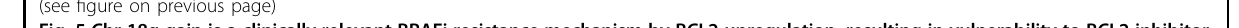
Fig. 5 Chr 18q gain is a clinically relevant BRAFi resistance mechanism by BCL2 upregulation, resulting in vulnerability to BCL2 inhibitor. a Cell viability of the captured clones in response to ABT263. Results are representative of two independent experiments with three technical replicates per experiment, and error bars represent SEM. b Heatmap showing the IC 50 of cells treated with ABT263. c Colony formation assay of cells treated with the indicated drugs. Representative image of three independent replicates. d A violin plot with integrated boxplot showing mRNA expression of BCL2 of BRAFi pre- and post-treatment resistant samples from a published cohort 54 . e Heatmap showing cluster and expression of BCL2 and genes from chr 18q21.33 (labeled in red) or randomly chosen genes from other genomic loci. f , g Pearson correlations of BCL2 expression with the degree of tumor regression (Response Evaluation Criteria in Solid Tumors (RECIST)) or progression-free survival (PFS) from reanalysis of a published cohort 54 . h A boxplot showing Bcl2 expression (FPKM) of paired PLX-treated tumor biopsies (Initial vs Progressed) from a published cohort 55 . i Western blot results showing Bcl2 protein expression of three BRAF mutant melanoma cell lines that were selected for resistant cells by PLX treatment (2 µM for WM2664, 2 µM for SK-MEL-5, and 5 µM for A2058) for 40 days. P parental cells, R1 replicate 1 of PLX-treated cells, R2 replicate 2 of PLX-treated cells. The numbers showing the relative quanti fi cation of Bcl2 bands intensity normalized to a housekeeper (tubulin) and referred to the parental sample of each cell